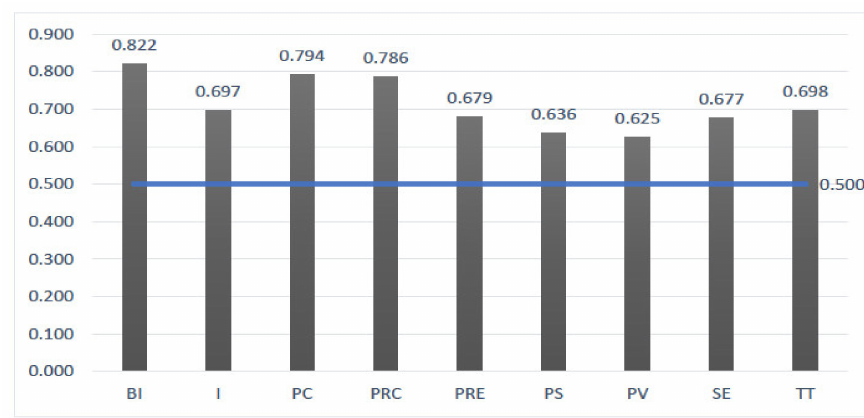
Figure 2. Composite Reliability.